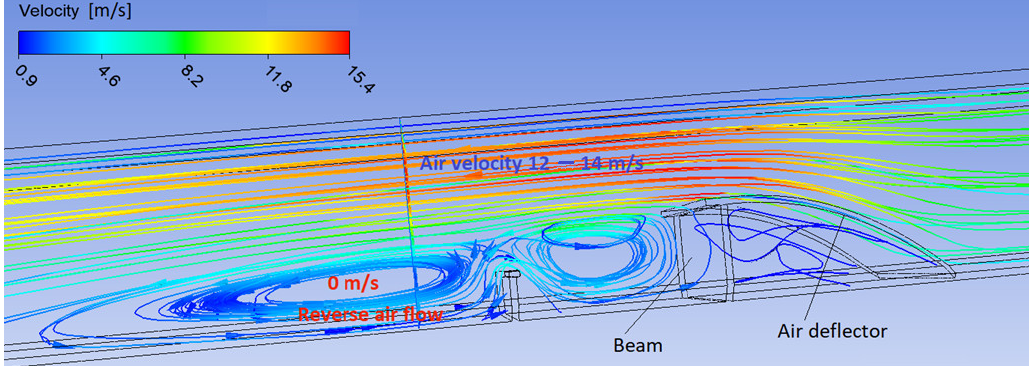
Figure 12. Streamlines; CFD model with a beam size of 288 mm with deflector upstream the beam.